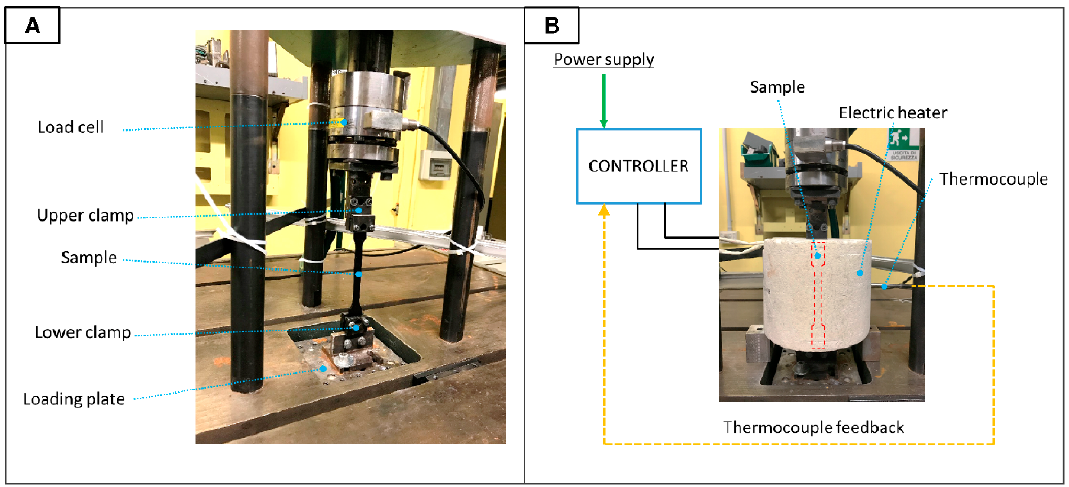
Figure 1. Experimental set-up for room temperature tests ( A ) and high temperature tests ( B